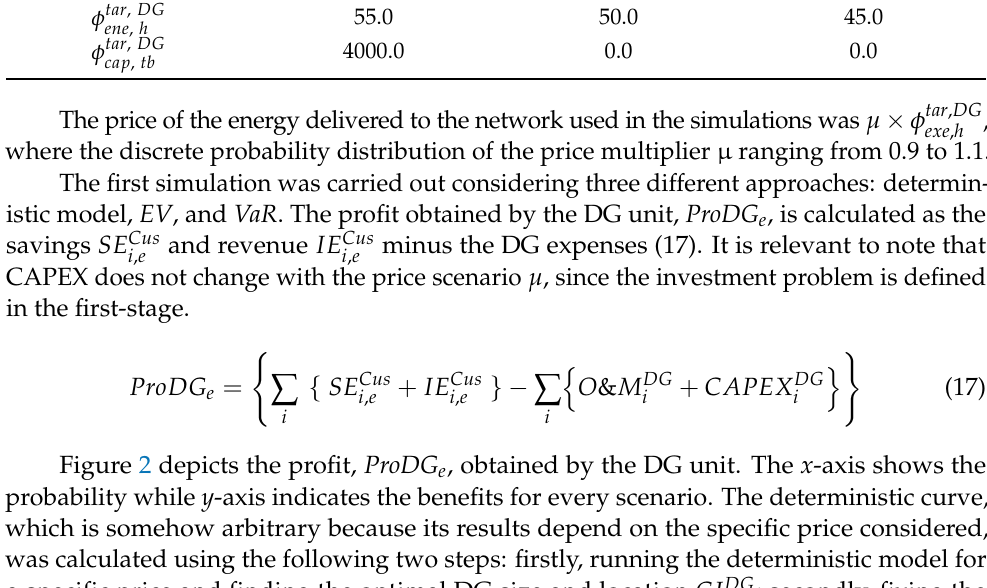
Table 1. Customer energy and capacity tariff. ToU Peak Base Valley 55.0 50.0 45.0 φ tar , DG ene , h 4000.0 0.0 φ tar , DG cap , tb